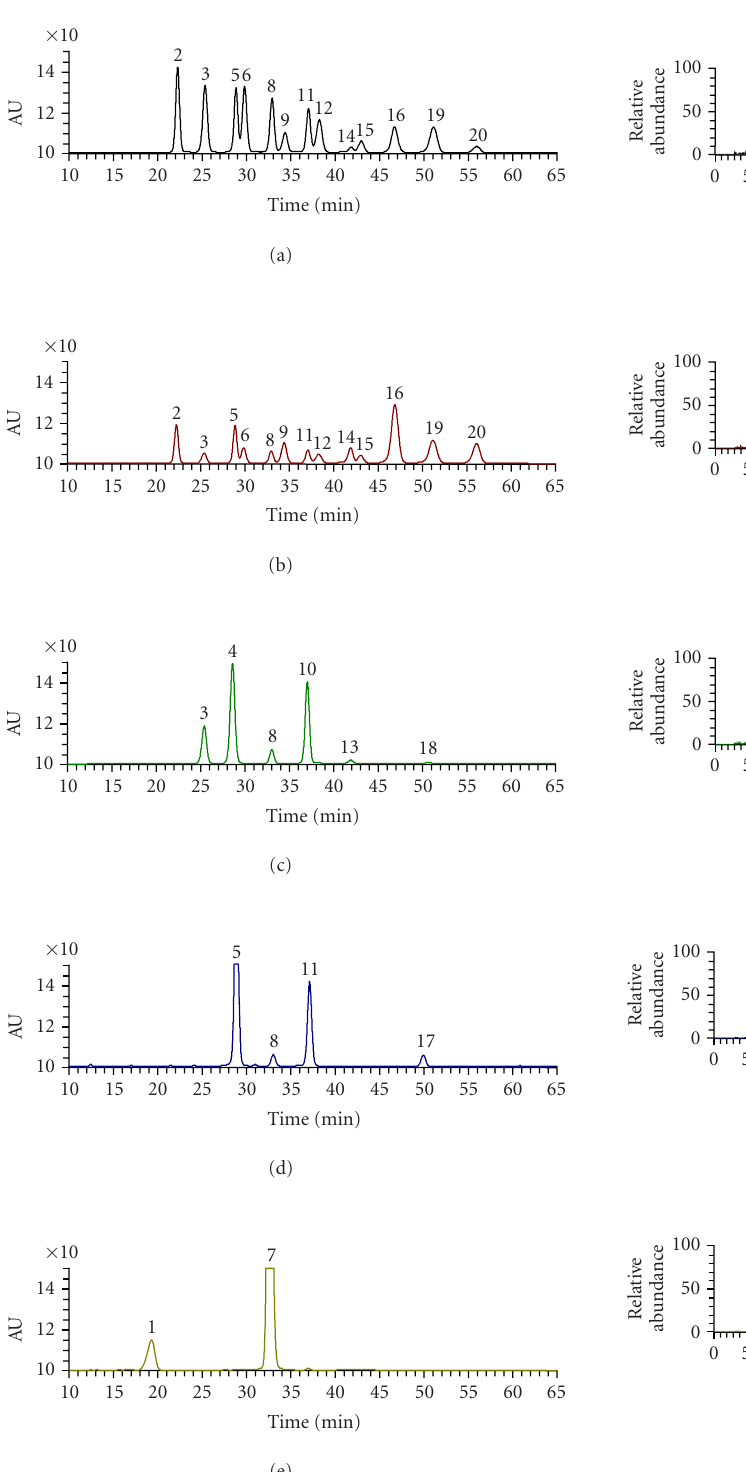
Figure 3. Mass chromatogram of bilberry extract selected by m/z of each aglycon. Mass chromatogram revealed that bil- berry extract contains 15 anthocyanins; nevertheless, the ex- tract showed only 13 peaks on PDA. The peaks of 16 and 19 in Figure 2 overlap with 16a and 16b, and 19a and 19b, respec- tively. (a) Delphinidin ( m/z = 303); (b) cyanidin ( m/z = 287); (c) petunidin ( m/z = 317); (d) peonidin ( m/z = 301); (e) mal- vidin ( m/z =